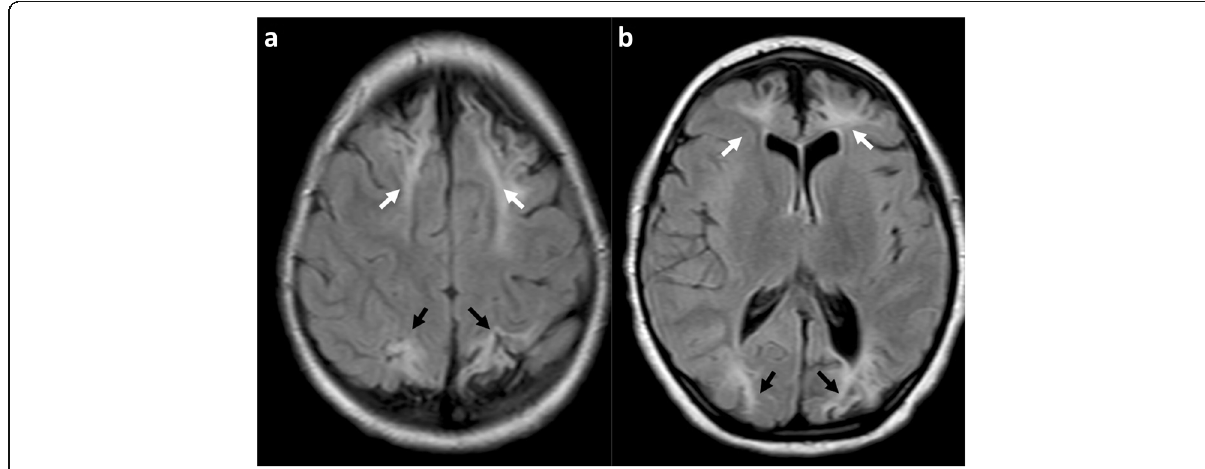
Fig. 3 a , b Sequential axial FLAIR images in a 4-year and 9-month-old girl, who sustained a partial-prolonged hypoxic-ischaemic injury at term gestation during prolonged labour, demonstrating bilateral, symmetric volume loss with abnormal underlying white matter high signal in the anterior watershed (white arrows), apparently discontinuous from similar involvement of the posterior watershed (black arrows). This is perceived as a classical watershed distribution but does not demonstrate the watershed continuum in its